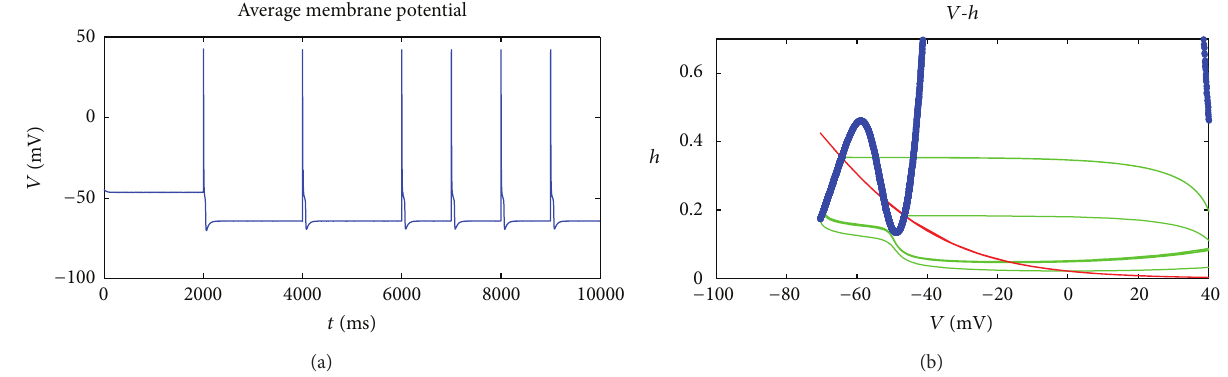
Figure 7: Average membrane potential 𝑉 and h-V phase plane when 𝑔 𝑘 = 0.1 mS / cm 2 and 𝑔